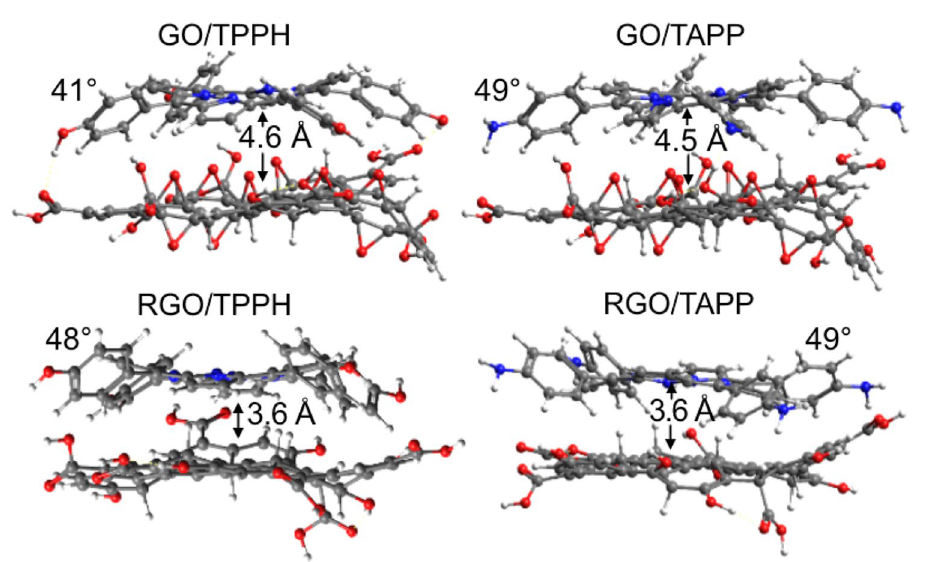
Figure 5. Geometries of the optimized nanohybrids. Highlighted are the distance between porphyrin and GO/ RGO planes as well as dihedral angle that describes the porphyrins’ phenyl ring out-of-plane